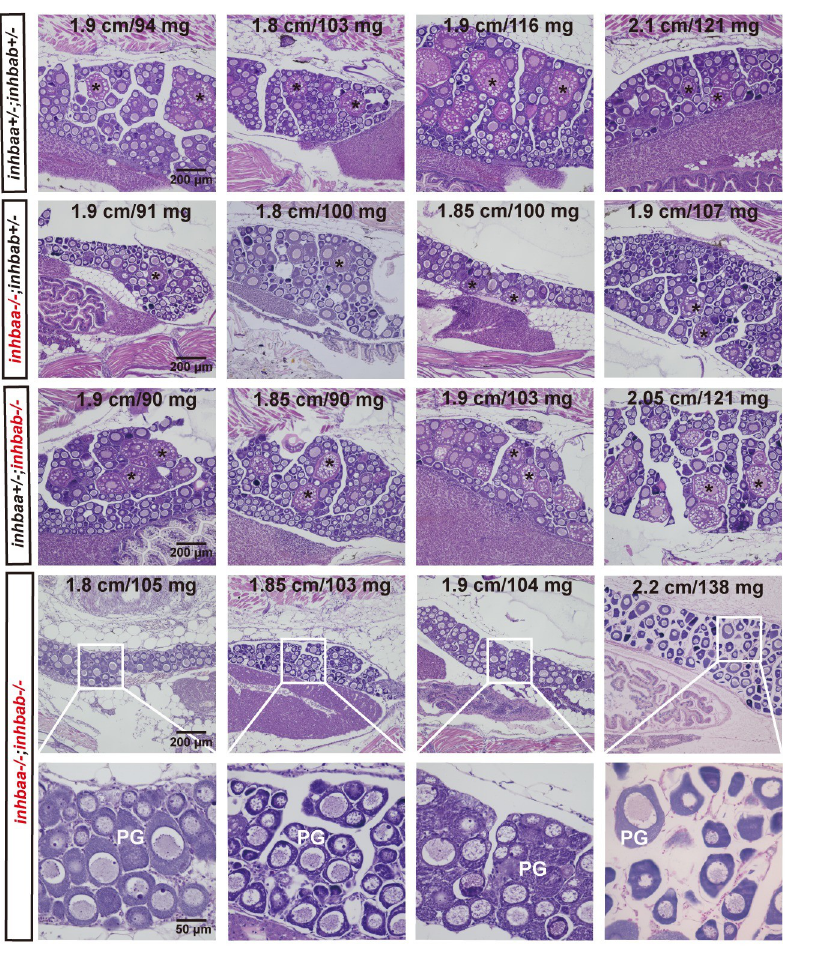
oocyte started to appear when their BL and BW reached the threshold for puberty onset (1.80 cm/100 mg). However, in the double mutant ( inhbaa -/-; inhbab -/-),PV follicles did not appear in many individuals although their body size had reached the threshold. The BL (cm) and BW (mg) of each fish are shown on the top. The asterisk shows PV follicles. PG, primary growth